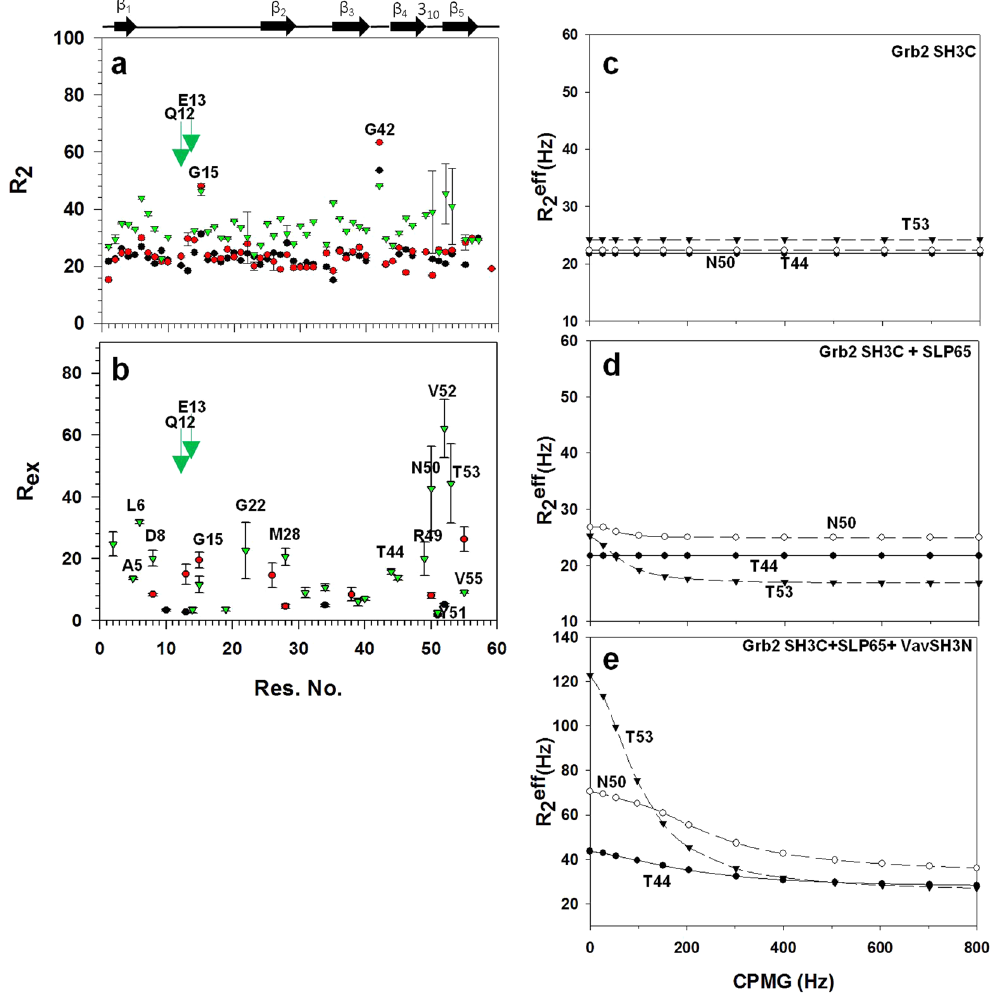
Figure 9. Analysis of the 15 N relaxation dispersion experiments. ( a ) Changes in R 2 as a function of residue number for the free Grb2 SH3C (black), Grb2 SH3C in complex with the SLP65 peptide (Complex 1, colored red), and Grb2 SH3 in complex with SLP65 peptide and Vav SH3N domain, (Complex 2, trimeric complex, colored green). R ex as a function of residue number for the ( b ) free Grb2 SH3C (black), Grb2 SH3C in complex with the SLP65 peptide (Complex 1, red), and Grb2 SH3C in the SLP65-Grb2-Vav trimeric complex (Complex 2, green). 15 N constant time relaxation dispersion profile for Thr 44, Asn 50, and Thr 53, in the ( c ) free Grb2 SH3C domain, ( d ) Grb2 SH3C domain in complex with the SLP65 peptide (Complex 1), and ( e ) Grb2 SH3C in the trimeric complex (Complex 2). The data was acquired at 298 K on a 700 MHz Bruker Avance III NMR spectrometer, equipped with a cryoprobe. The data was processed using nmrPipe 56 and analyzed using Sparky 57 and NESSY 62